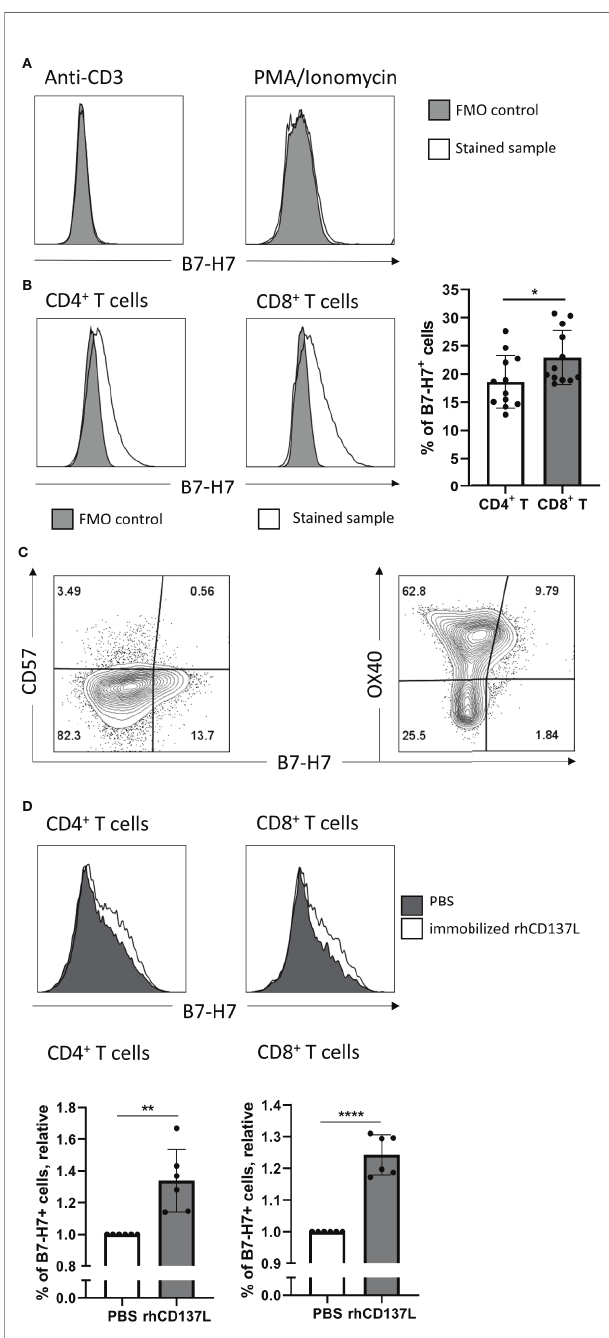
FIGURE 2 | Induction of B7-H7 expression on T cells upon activation. (A) Expression of B7-H7 in T cells activated with CD3 crosslinking or PMA/ ionomycin for 72 and 24 hours respectively, n=2. (B) Expression of B7-H7 in CD4 + and CD8 + T cells upon crosslinking of CD3 and CD28 for 72 hours, n=12. (C) Expression of B7-H7, CD57, and OX40 in total T cells upon crosslinking of CD3 and CD28 for 48 hours, n=4. (D) Expression of B7-H7 of TransAct ™ activated T cells in the presence or absence of rhCD137L, n=6. Cells were gated for live and single cells, *p < 0.05, **p < 0.01, ****p < 0.0001, unpaired Student ’ s T